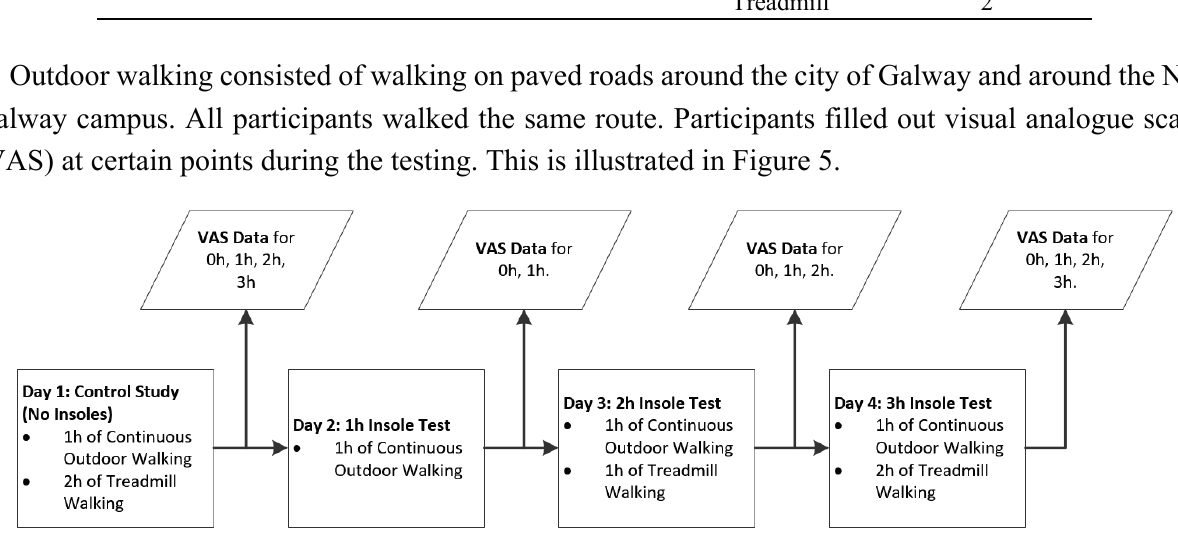
Figure 5. Procedure for testing insole comfort with young healthy